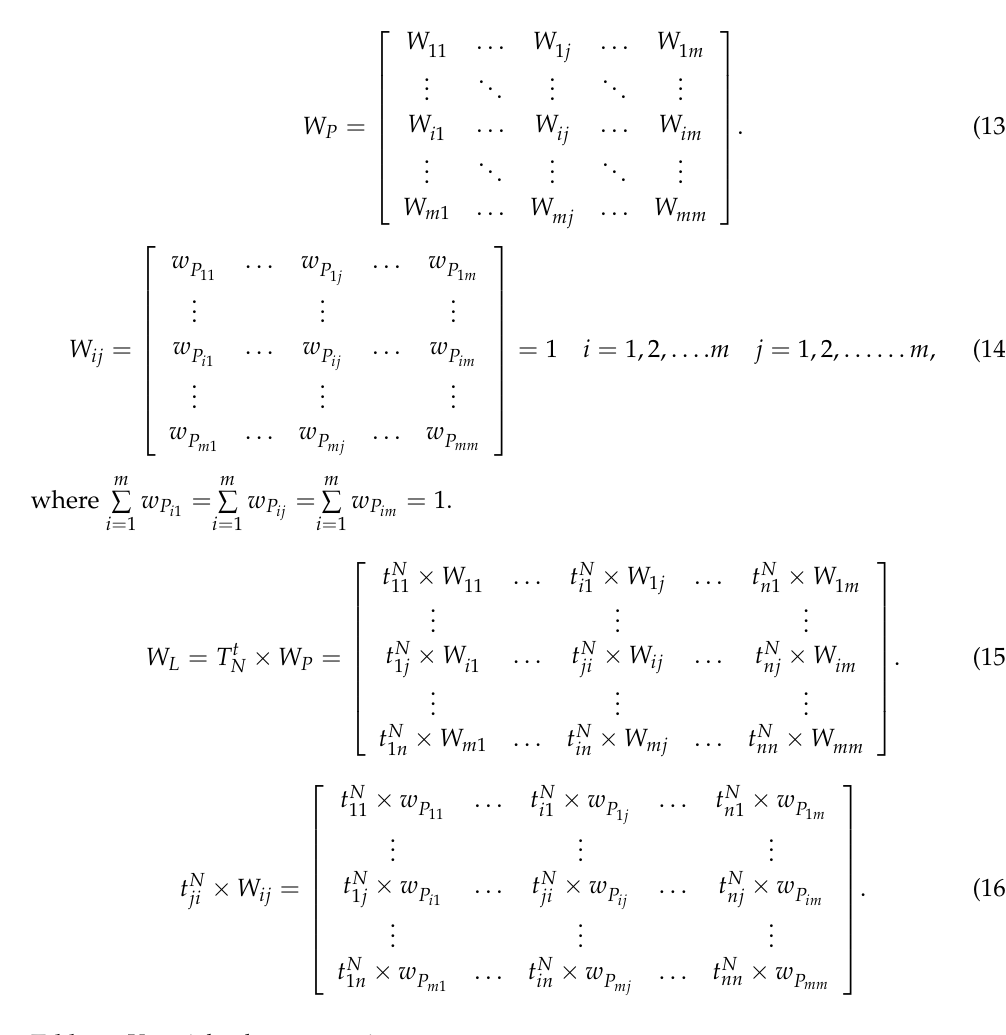
Table 10. Unweighted super-matrix.